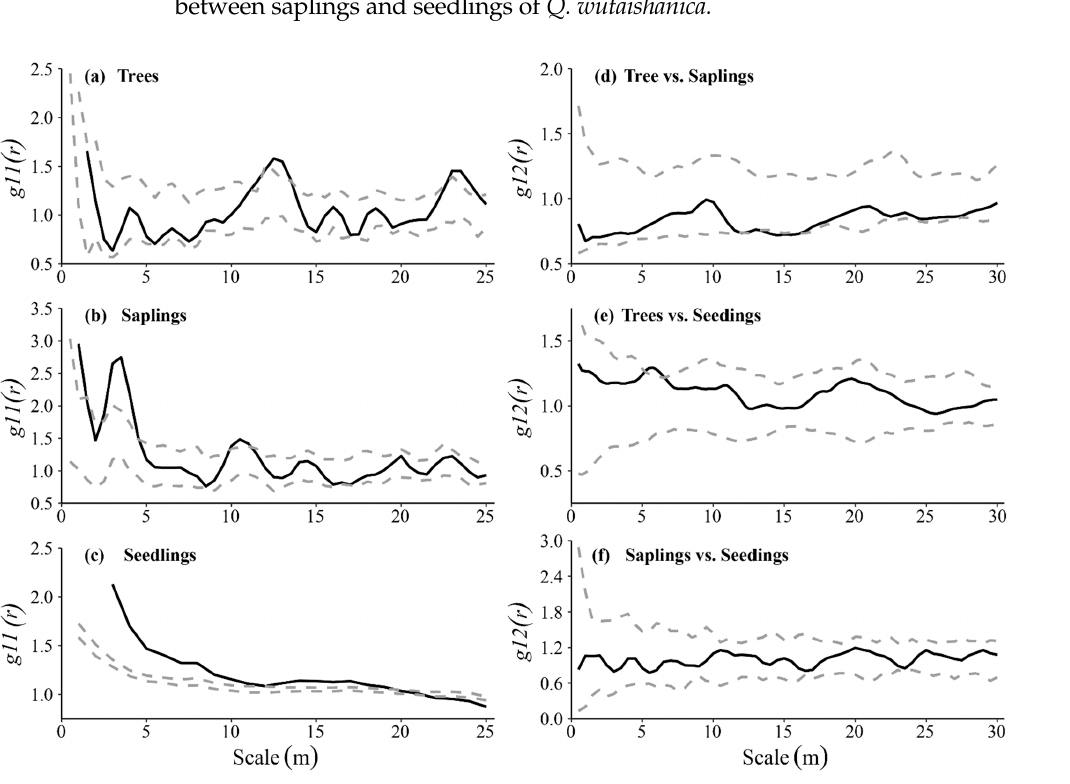
Figure 3. Univariate point pattern analyses show the spatial pattern using the pair-correlation func- tion ( a – c ), and bivariate point pattern analyses show intra-species spatial associations among three size classes ( d – f ) of Q. wutaishanica. Black lines indicated the g11(r)/g12(r) function, dotted lines in- dicated the upper and lower limits of the 99% confidence interval.